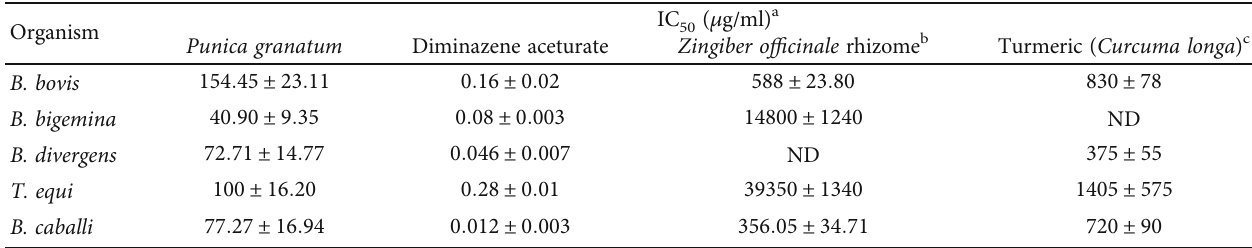
Table 1: IC values of pomegranate ( Punica granatum ) peel, diminazene aceturate, and other previously used herbal antibabesial drugs 50 evaluated for bovine Babesia and equine Babesia and Theileria parasites. Organism